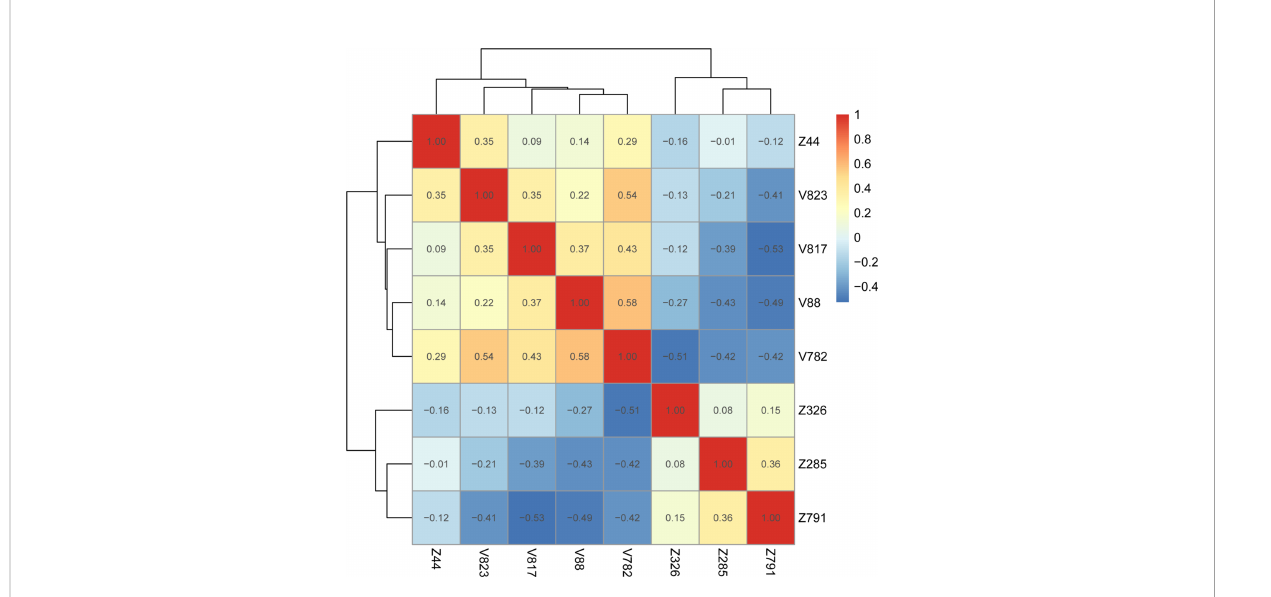
FIGURE 6 Gross radiology model feature correlation heatmap. V represents intranodular features, and Z represents peri-nodular features (Supplementary Table 2).